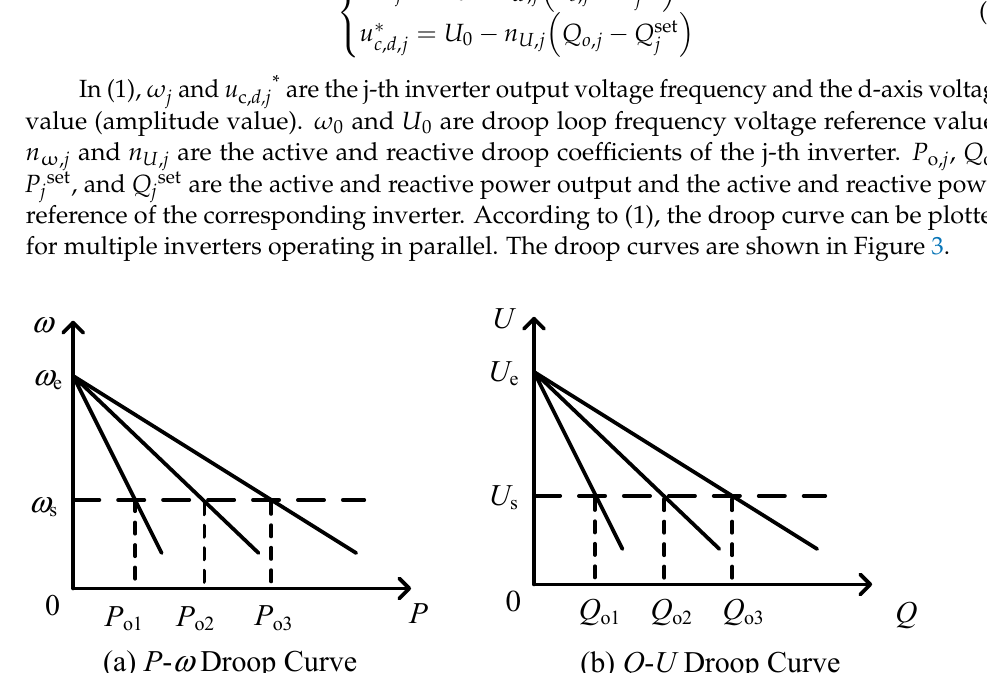
Figure 2. Control block diagram of the droop-control inverter.